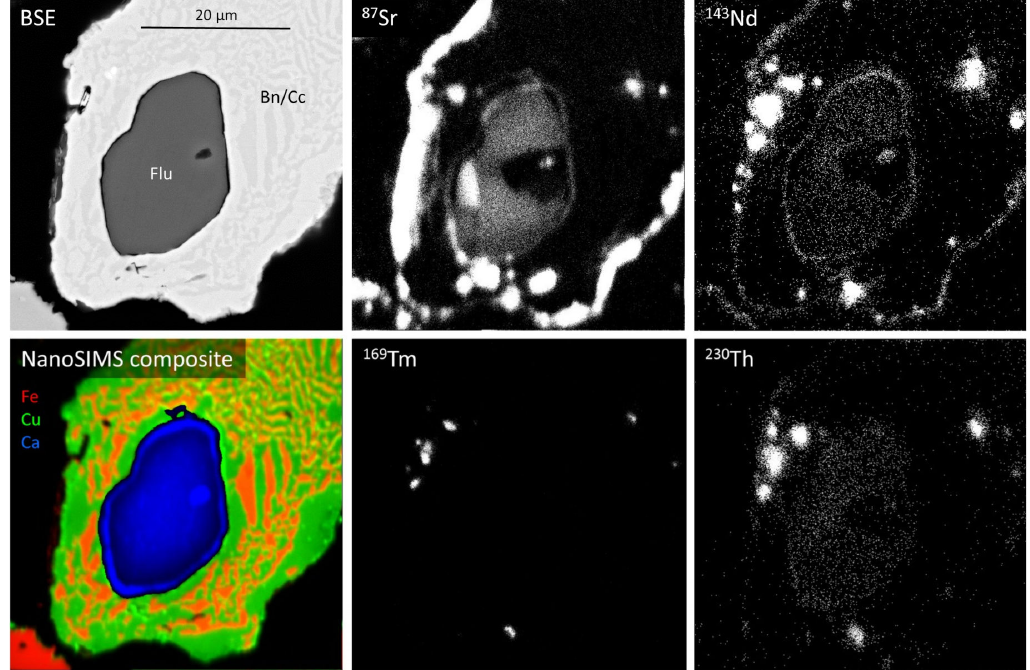
Figure 6. The BSE and nanoSIMS images of sample 05CLD86 showing corroded / resorbed fluorite (Flu) within the symplectitic intergrowth of chalcopyrite and bornite. The composite image represents overlapping nanoSIMS maps of Fe (red), Cu (green), and Ca (blue). Note that orange is the result of a red and green overlap (in this case, bornite). Sr 2 + commonly substitutes for Ca 2 + in fluorite, frequently resulting in intricate zoning patterns. LREE, represented here by 143 Nd, is associated positively with Sr in the fluorite, but HREE is